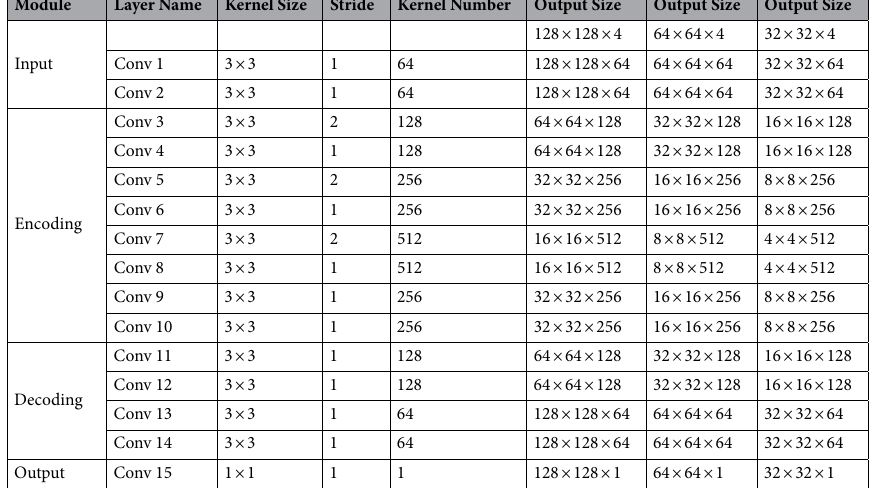
Table 3. Network structure of the